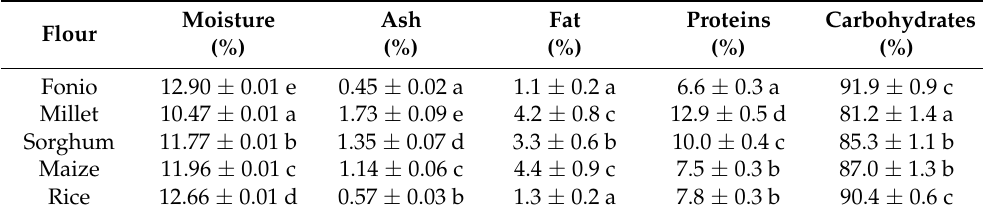
Table 1. Proximal composition of fonio compared to the other gluten-free flours. Except for the moisture content, all presented values are referred to dry